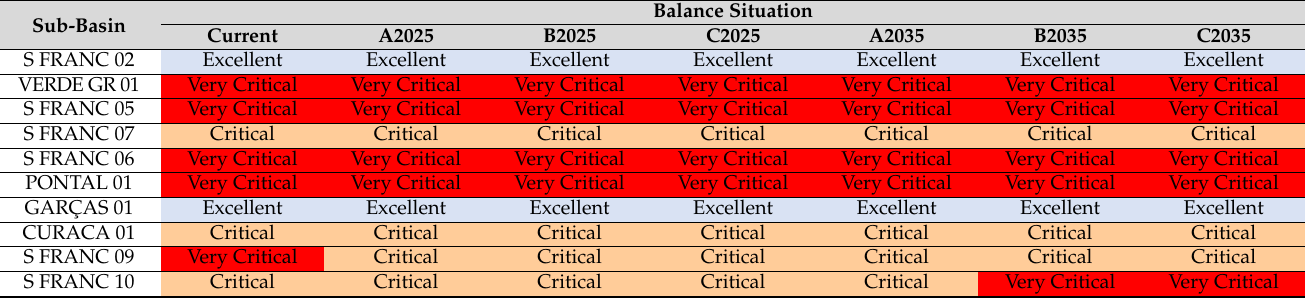
Table 6. Examples of surface water balance (Acquanet)—domestic urban and rural supply. See Table 2 for the corresponding classification. See Supplementary Materials